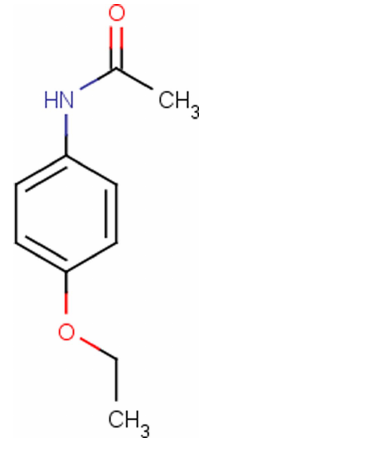
Figure 1 Chemical structure of phenacetin